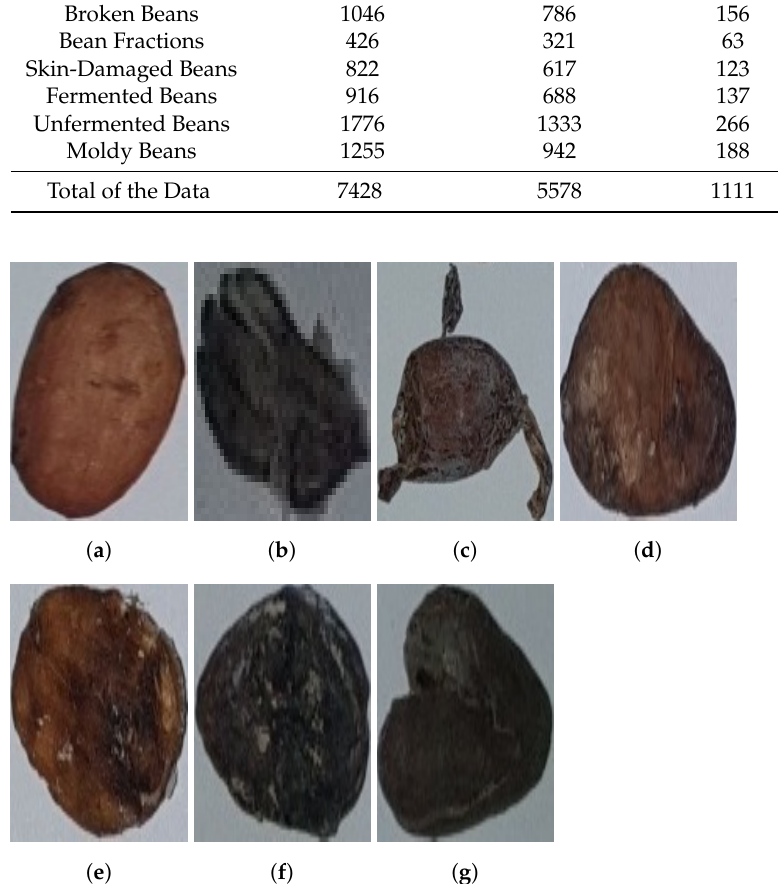
Figure 4. Cocoa Bean Image collected from Indonesian cocoa bean factory, Sulawesi, Indonesia [31]. ( a ) Whole Beans. ( b ) Beans Fractions. ( c ) Skin-Damaged Beans. ( d ) Fermented Beans. ( e ) Unfermented Beans. ( f ) Moldy Beans. ( g ) Broken